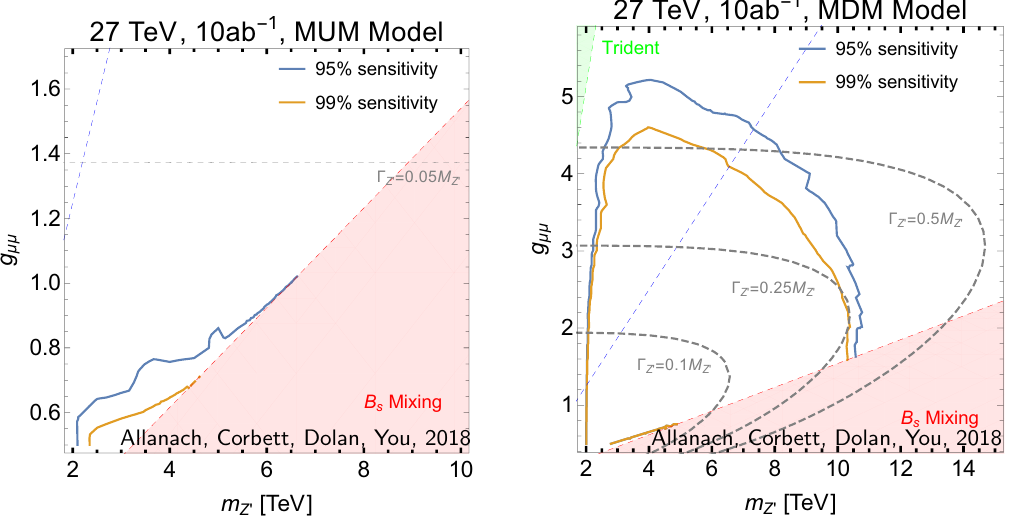
Figure 9 . Predicted sensitivity for the 27 TeV HE-LHC with 15/ab integrated luminosity in the M Z 0 { g (cid:22)(cid:22) plane. Each point in the plane (cid:12)ts the neutral current B -anomalies, since eq. (2.2) with x = 1 : 00 has been enforced meaning that g bs / M 2 =g (cid:22)(cid:22) . The solid lines show the regions of 95% Z 0 CL and 99% CL sensitivity, which are below each contour. The left-hand plot shows the MUM model, the right-hand plot the MDM model. In order to show more of the parameter space, we have displayed the pre-2016 B s mixing constraint in pink and the one based on eq. (2.3), where the region below the blue dashed line is ruled out. The grey dashed lines show contours of the relative decay width (cid:0) Z 0 =M Z 0